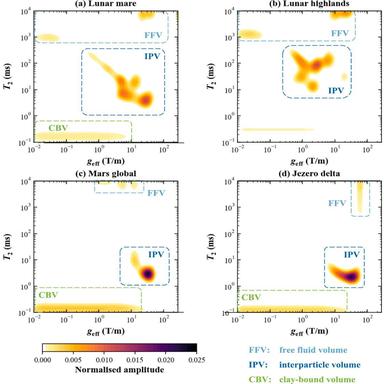
Measured T2-geff distributions quantifying the joint spin-spin relaxation and internal gradient environment experienced by water in the pore space. Measurements are conducted on fully saturated samples, for: (a) Lunar Mare, (b) Lunar highlands, (c) Mars global and (d) Jezero delta simulants. In each distribution, we have indicated the regions suggested to correspond to the free fluid volume (FFV), interparticle volume (IPV) and clay-bound volume (CBV).